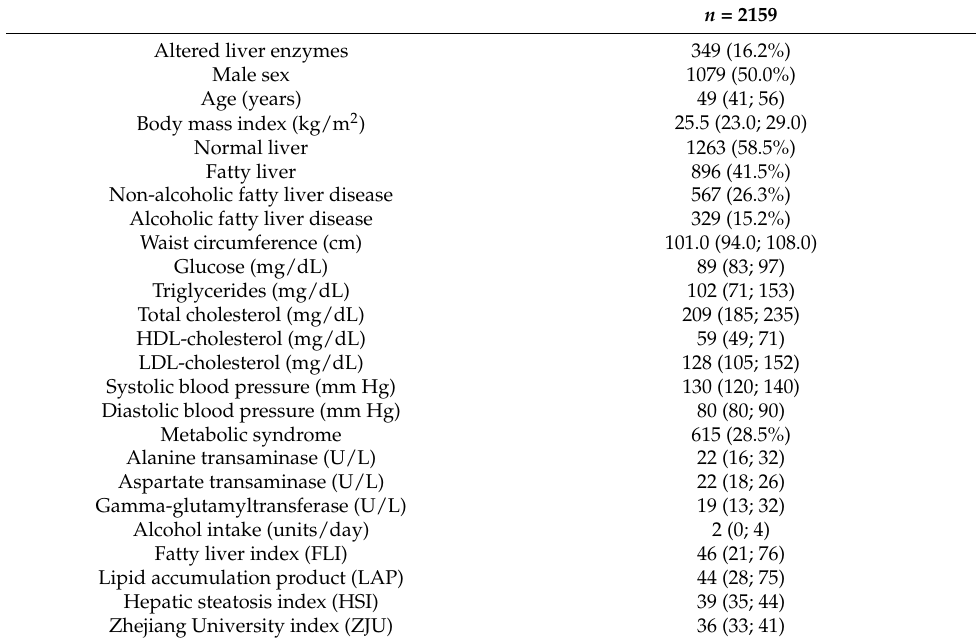
Table 1. Measurements of the study